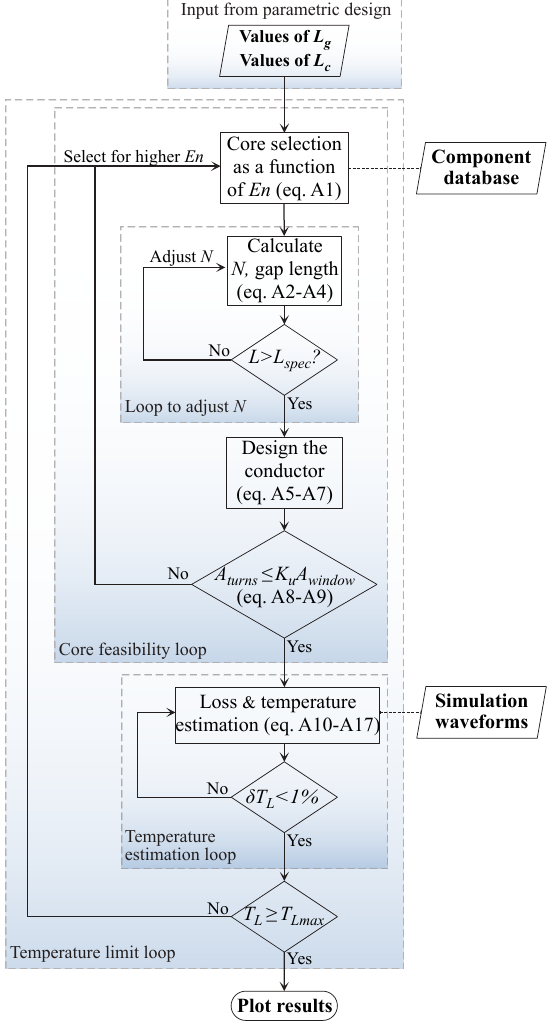
Figure A1. Inductor hardware design